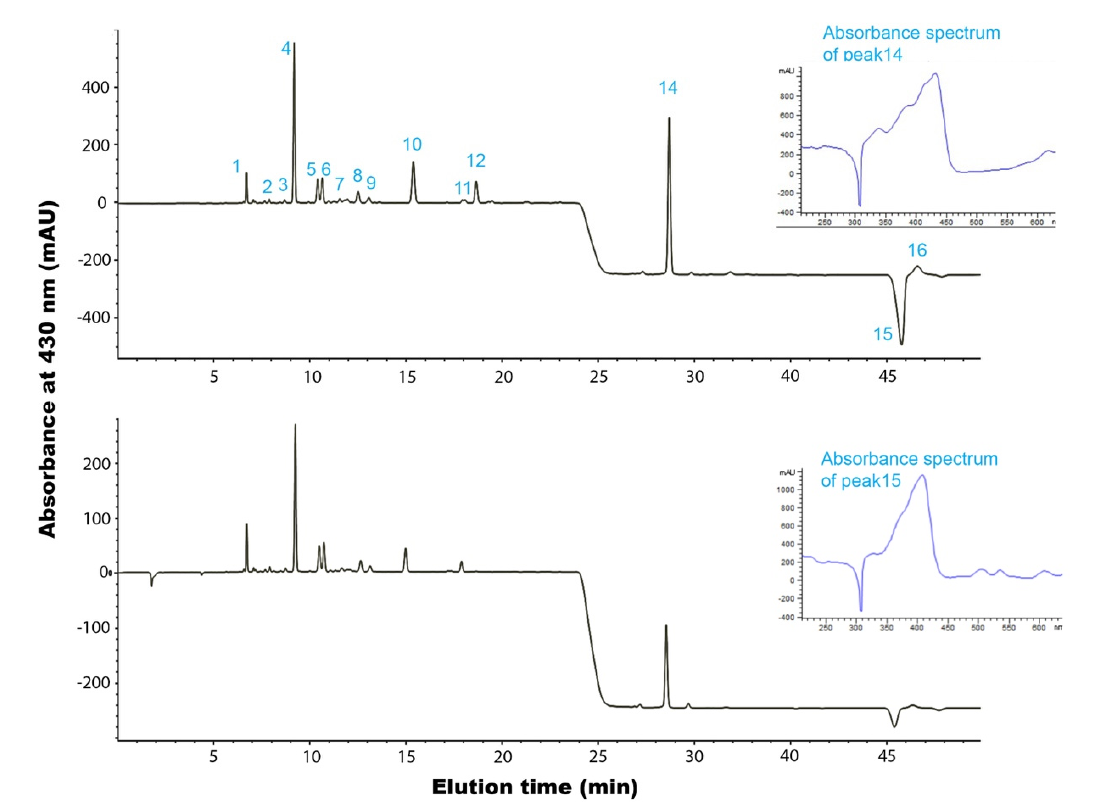
Figure 2. Typical HPLC chromatographs at 430 nm of the EtOH-UAE extract (upper) and the BP extract (lower). At this wavelength, phaeophytin (peak 15) appears as a negative peak. The UV-vis spectra of peaks 14 and 15 are shown. The peaks are numbered as in Table 3. Table 3. Identification and quantification of the main compounds of the two extracts, the EtOH- UAE and the BP. Peaks were tentatively identified after comparison of the UV-vis maxima obtained by the HPLC-DAD and UHPLC-DAD-MS analysis, the ions observed in the mass spectra after